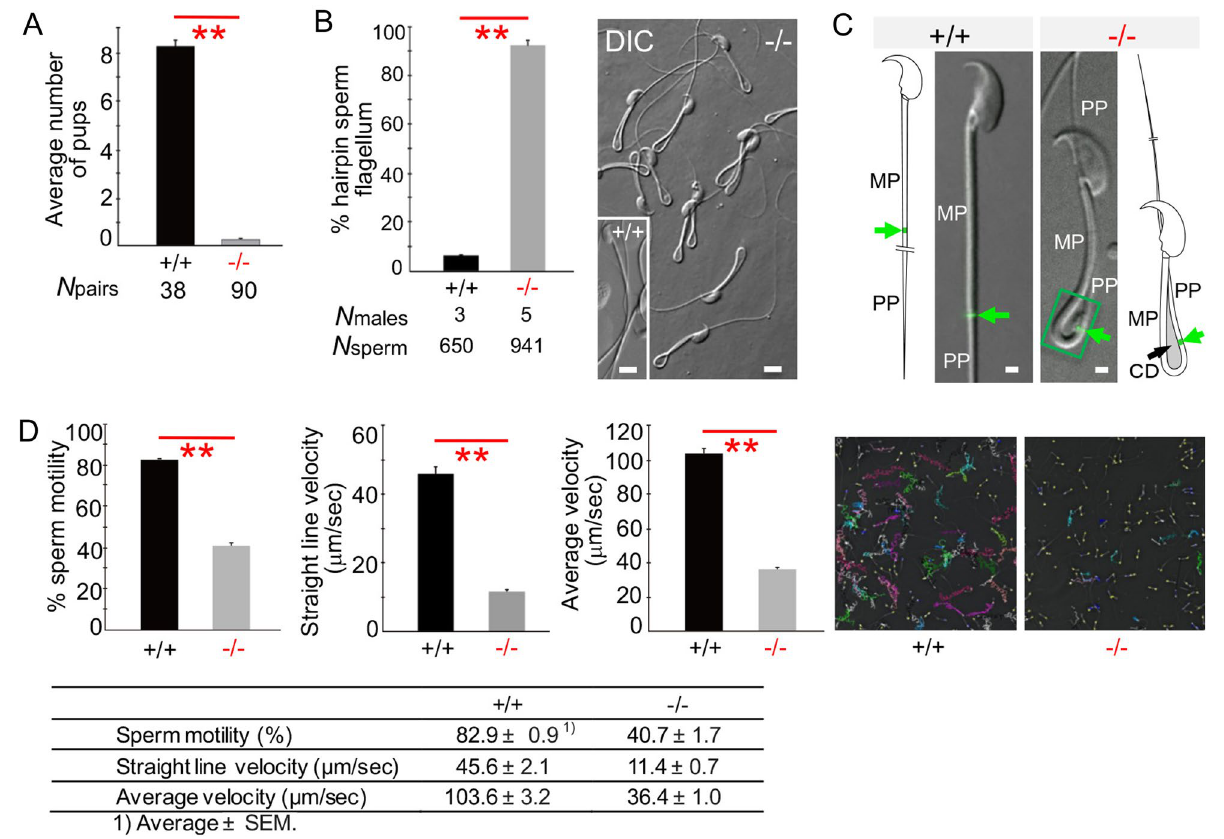
Figure 2. Phenotype of Odf4 −/− males and spermatozoa. + / + : Odf4 +/+ . −/−: Odf4 −/− . ( A ) Odf4 −/− males are infertile. Average number of pups (fertility rate): 8.2 ± 0.3 (+ / +) versus 0.3 ± 0.1 (−/−). Data are presented as the average ± standard error of the mean. The p value was calculated using the Mann ‒ Whitney U test (two- tailed analysis) using the add-in Statcel 3 software (OMS) for Microsoft Excel. ( B ) Postcopulatory hairpin sperm flagella. (Left) Percentage (%) of hairpin sperm flagella: 6.3 ± 0.8 (+ / +) versus 92.3 ± 1.9. Student’s t test (two-tailed analysis). (Right) DIC images. Inset: + / + . Scale bar = 5 μm. ( C ) Cytoplasmic droplet (CD) shown by immunofluorescence with an antibody against SEPTIN 7 (green signal: arrows) for Odf4 −/− and Odf4 +/+ cauda epididymal spermatozoa. CD is absent, but SEPTIN 7 is present at the annulus region in Odf4 +/+ . In contrast, both CD and SEPTIN 7 are present in the annulus region in Odf4 −/− mice. The internal component of the Odf4 −/− indicated at a rectangular area is further shown by TEM (Fig. 3D). MP: midpiece. PP: principal piece. Scale bar = 1 μm. ( D ) SMAS and the raw data showing the reduction in Odf4 −/− sperm movement. (Left) Percentage (%) sperm motility. (Middle left) Straight line velocity. (Middle right) Average velocity. All of these factors were significantly reduced in Odf4 −/− mice compared to Odf4 +/+ mice. Welch’s t test (two-tailed analysis). (Right) Representative images of SMAS before capacitation. (Bottom) The table shows raw data for SMAS. Odf4 −/− results in poor motility, where each color shows an individual spermatozoon. The total number of males (spermatozoa) examined was 3 (7,009) and 6 (14,911) for Odf4 −/− and Odf4 +/+ males, respectively. ** P < Odf4 −/− spermatozoa compared to that of Odf4 +/+ spermatozoa (Fig. 2D). Almost none of the Odf4 −/− spermato- zoa were able to progress forward, instead progressing backward with immotile midpieces (Videos S1 and S2 for Odf4 +/+ and Odf4 −/− , respectively). This motility characteristic is further quantitatively analyzed below (Fig. 6). AK1 and AK2 in spermatozoa and immunoprecipitation (IP). Next, we examined what kinds of flagellar proteins are present or absent in Odf4 −/− testicular and sperm cells using western blotting. For this pur- pose, to pay particular attention to the readily soluble form of ODF4 localized in the cytosol (here termed ‘solu- ble ODF4’), we collected the sample as described in detail in the Methods section; in short, we directly placed the samples without washing them into RIPA buffer containing 1% Nonidet P40. As a result, antibodies against AK1 and AK2 detected the corresponding signals in both control Odf4 +/+ testis and cauda sperm extracts and in Odf4 −/− seminiferous tubules cell extracts, but these signals were significantly reduced in Odf4 −/− mature sperm cell extracts (Fig. 4A Left and Fig. S6). Signals for all other proteins examined were detected in both Odf4 −/− and Odf4 +/+ cell extracts as follows: ODF1, ODF2, TEKTIN4, cation channel sperm associated 3 (CATSPER3), AQP3, AQP7, AQP8, SEPTIN 4, SEPTIN 7, solute carrier family 22 member 14 (SLC22A14), GAPDS, and GAPDH (Fig. 4A Right and Fig. S7). Next, we examined whether AK1 and AK2 can be coimmunoprecipitated with ODF4 in Tg(Odf4-Egfp) mice by IP using protein-G immunobeads conjugated with an antibody against GFP. For this